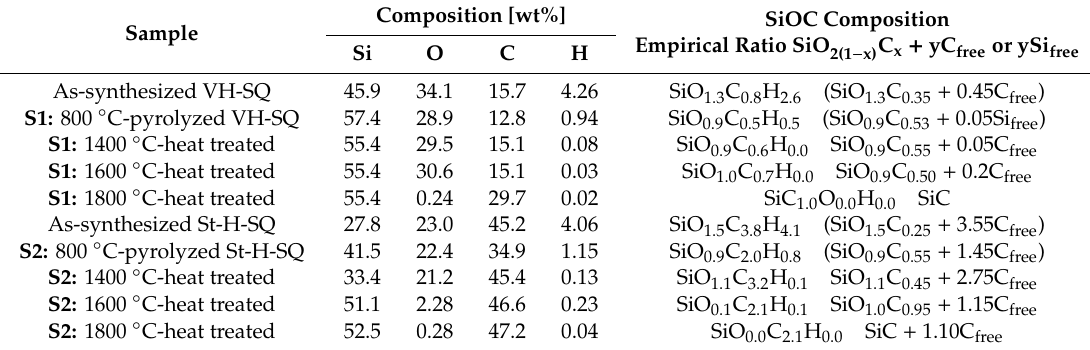
Table 1. Chemical composition of pyrolyzed and heat-treated samples.